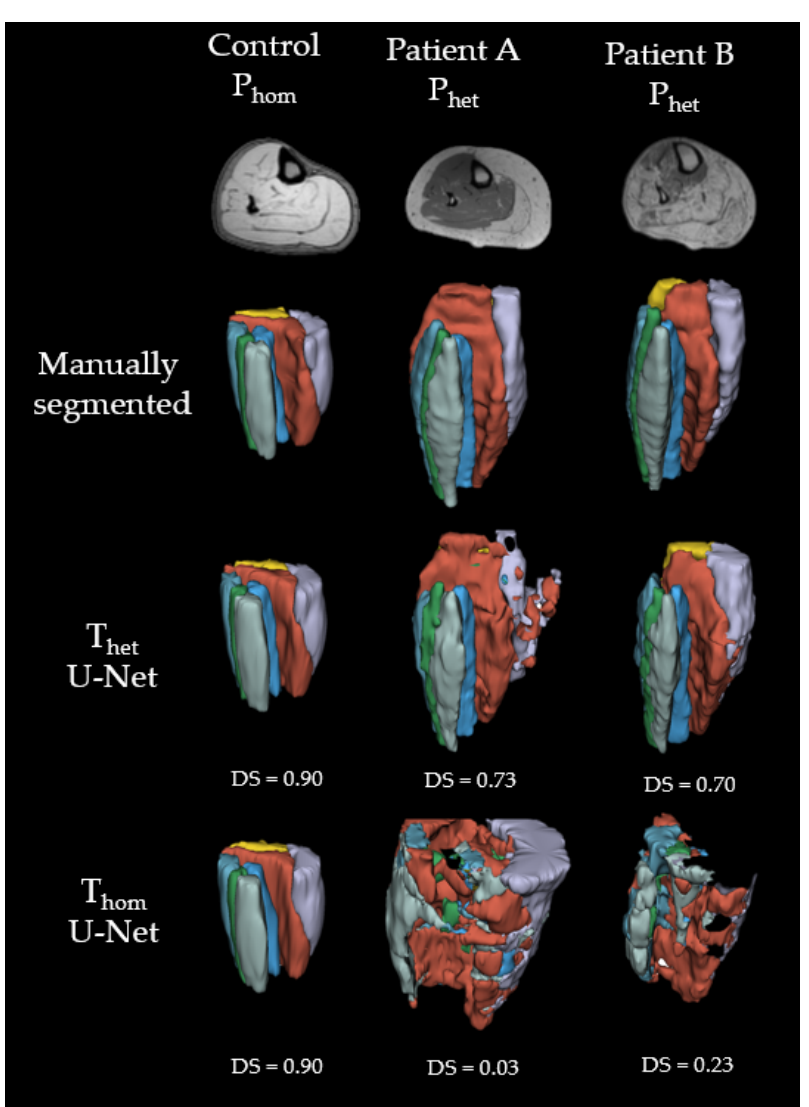
Figure 5. Examples of 3D labels predicted with U-Net. Green = extensor digitorum longus (EDL); purple = gastrocnemius lateralis (GL); yellow = gastrocnemius medialis (GM); light blue = peroneal group (PER); orange = soleus (SOL); mint = tibialis anterior (TA); blue = tibialis posterior (TP).